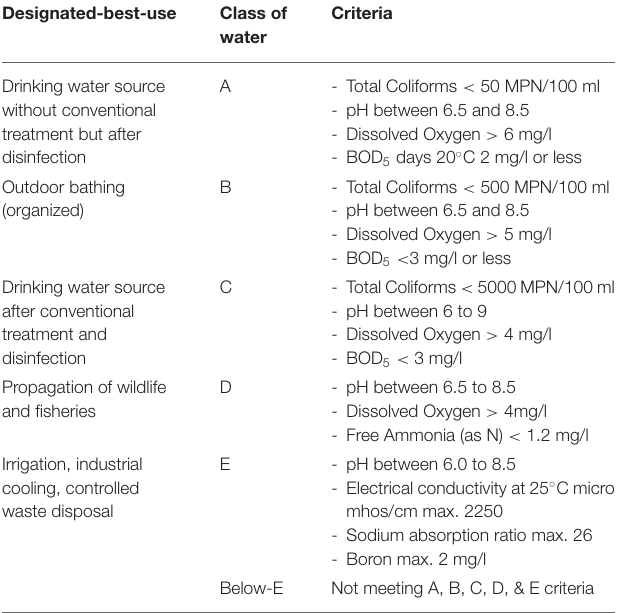
TABLE 4 | Water quality criteria under designated best use classes (CPCB, 2017a